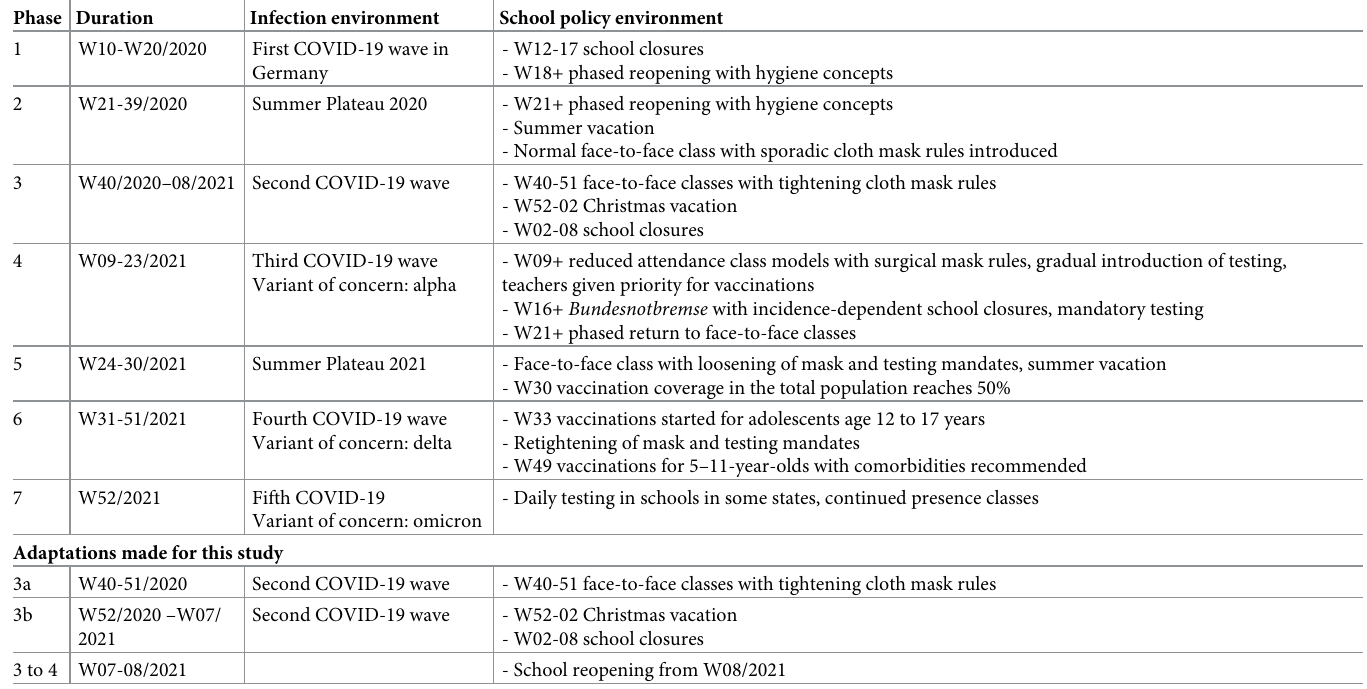
Table 1. Overview of the pandemic phases and outline of school